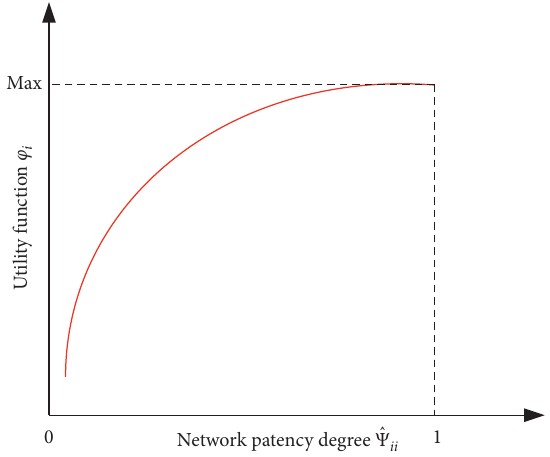
Figure 2: The relationship between utility function without penalty and network patency degree.